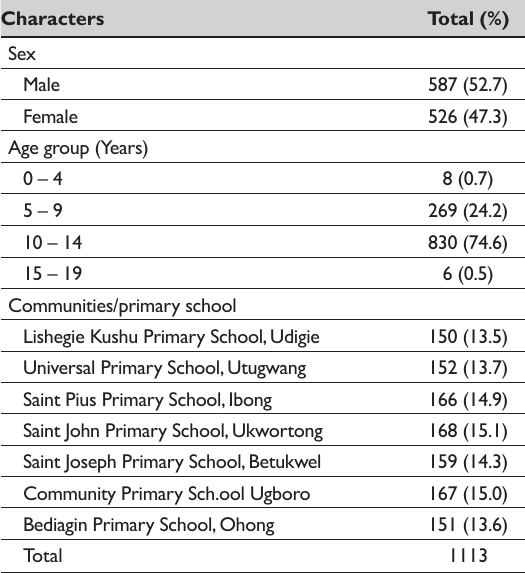
Table 1: demographic characteristics of the